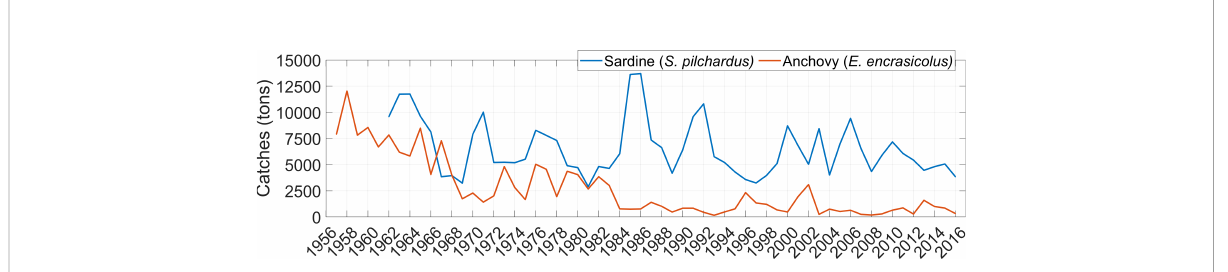
FIGURE 9 Time series of sardine (blue) and anchovy (red) landings in north Alboran. Data were obtained from the of fi cial statistics of the General Fisheries Secretariat (SGPM), Fisheries Regulatory and Market Fund (FROM), and the Spanish Institute of Oceanography